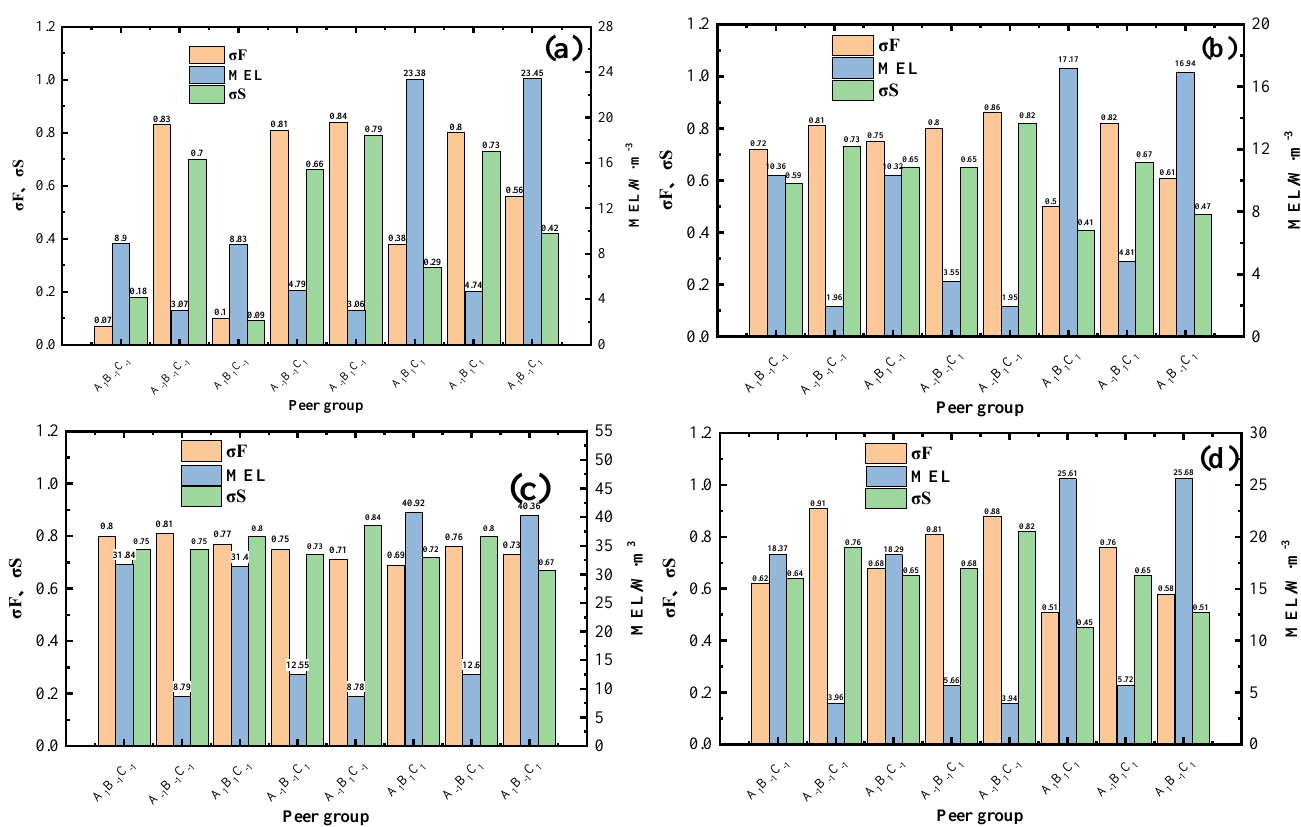
Figure 5. Full–factorial design response results: ( a ) PBT blade, ( b ) PBD blade, ( c ) BT blade, and ( d ) HBT blade.